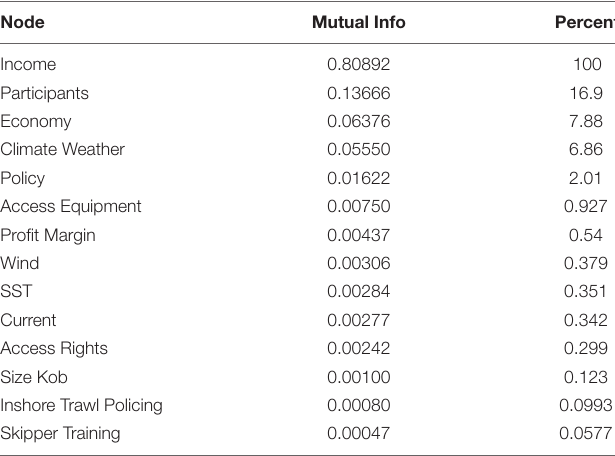
TABLE 4 | Sensitivity analysis of the BBN shows the variability of the priority variable to changes in the settings of all other variables in the BBN.